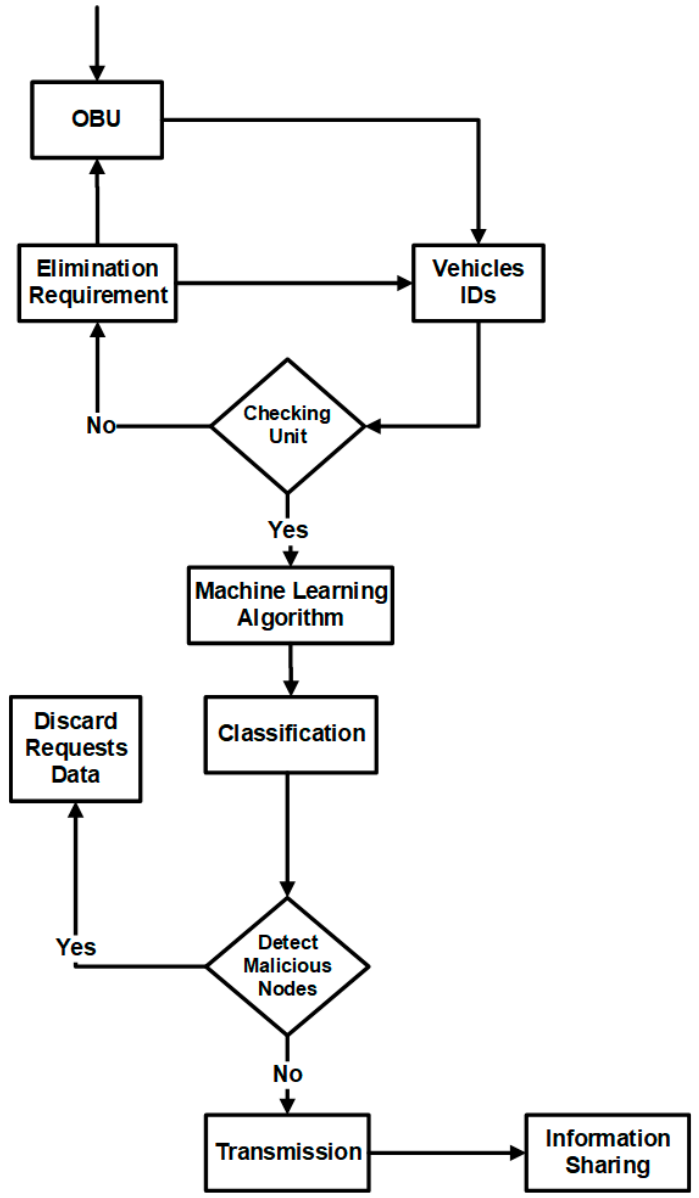
Figure 9. Logical workflow of the proposed methodology.